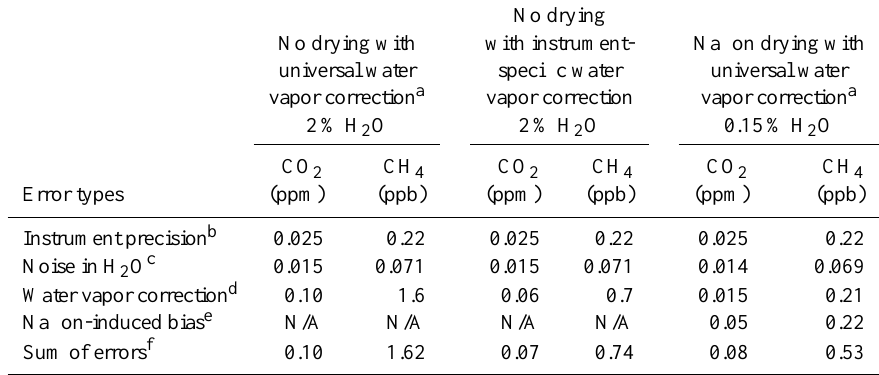
Table 2. Summary of errors for different CRDS application approaches.